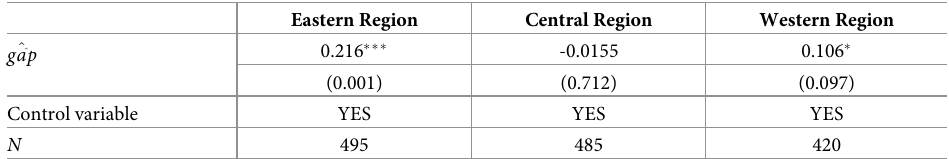
Table 8. Results based on regional